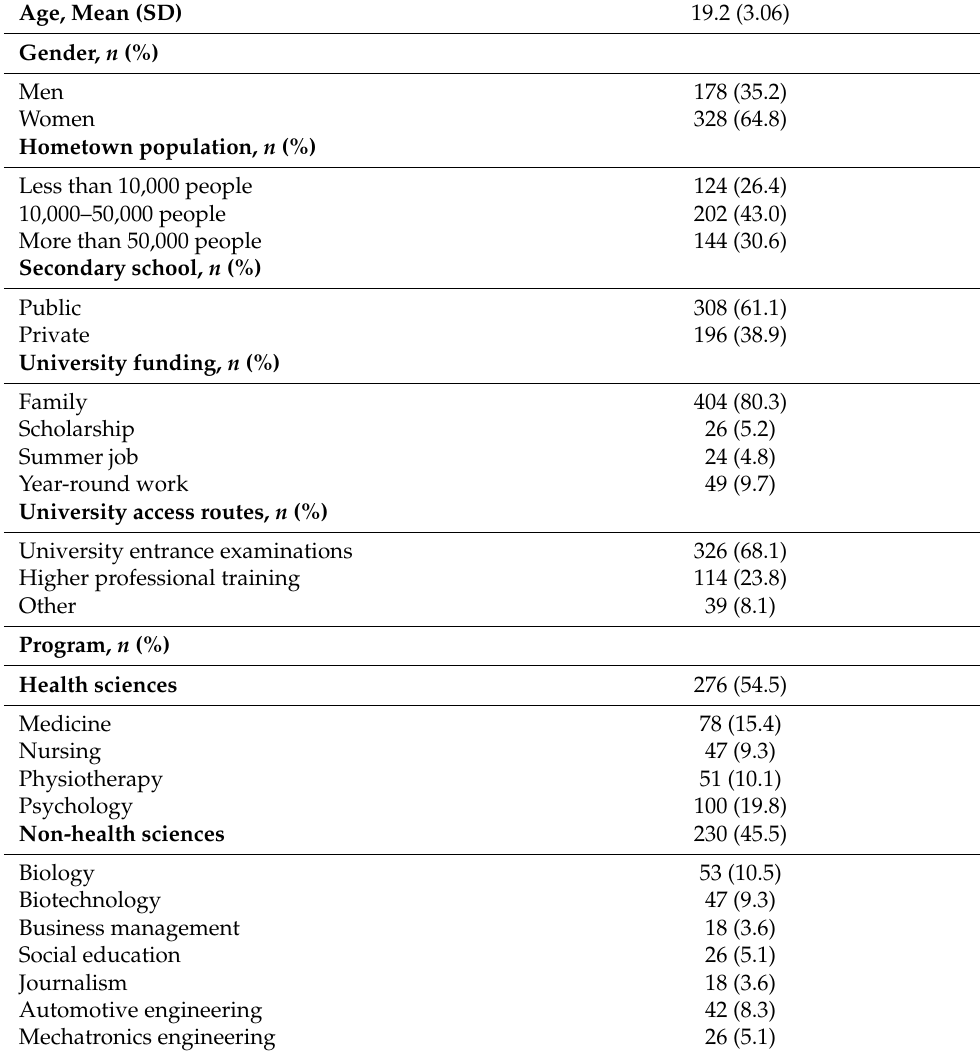
Table 1. Sociodemographic characteristics of the study sample ( n =